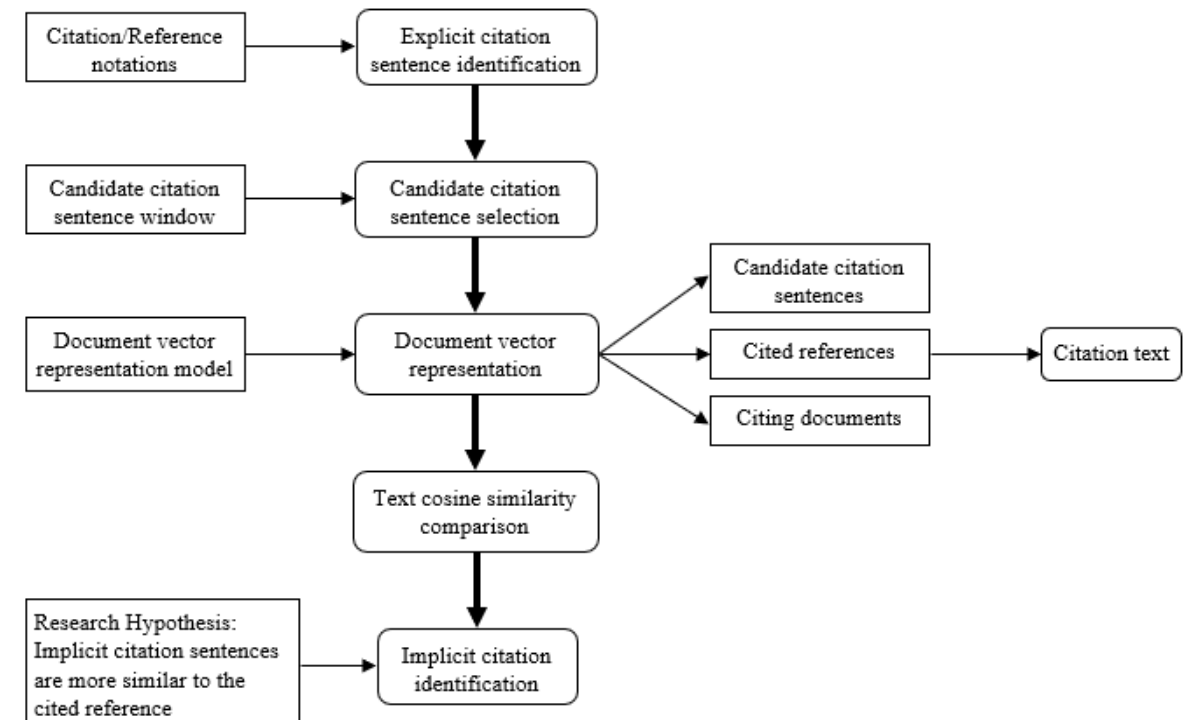
Figure 1. Method for identifying implicit citation